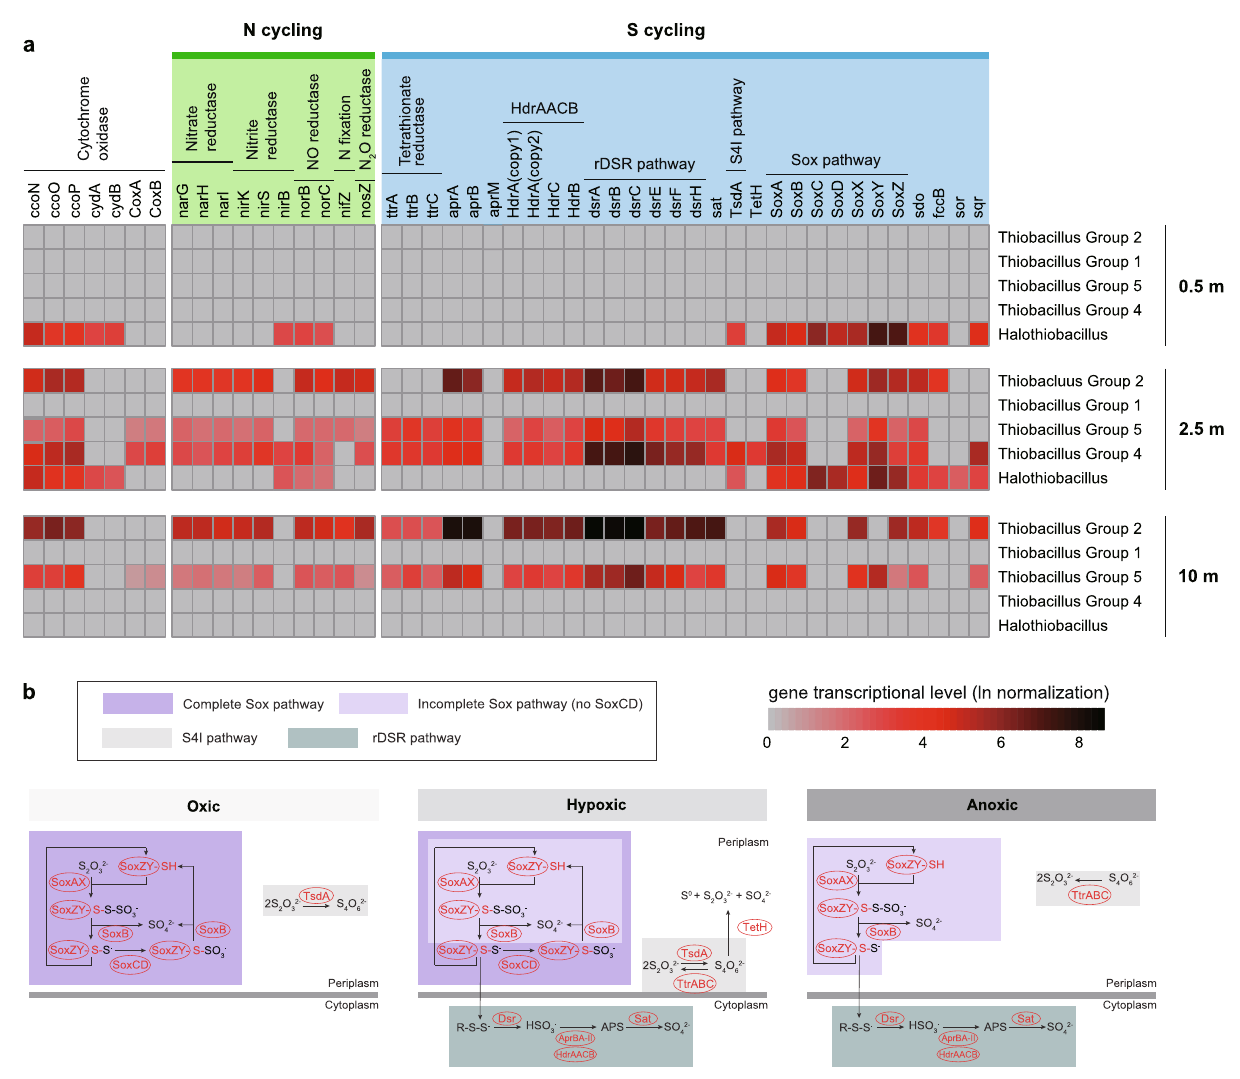
Fig. 4 | RNA expression activities and sulfur oxidation strategies revealed by metatranscriptomics.a August2018RNAexpressionlevelsofsulfuroxidativeand oxygen/nitrogen compound reductase genes of Halothiobacillus and Thiobacillus